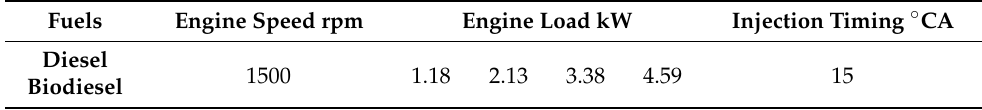
Table 2. Main characteristics of the test.